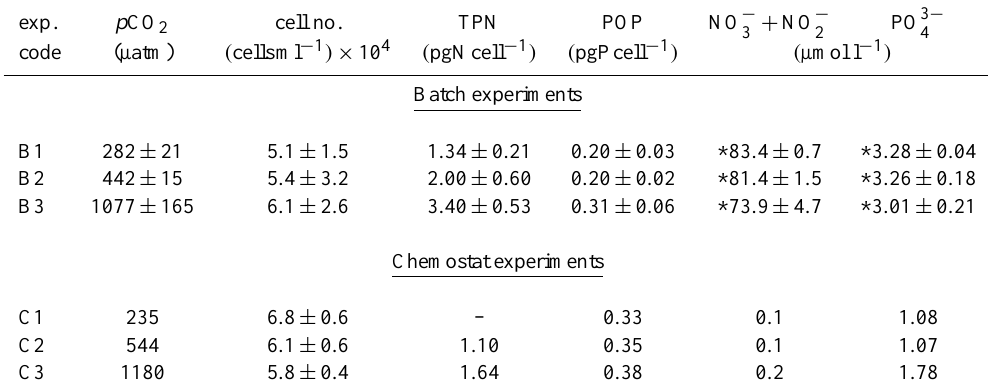
+ NO − and PO 3 − concentrations at the start of the batch experiments 3 2 4 + NO − and PO 3 − concentrations of the reservoir tanks during 3 2 4